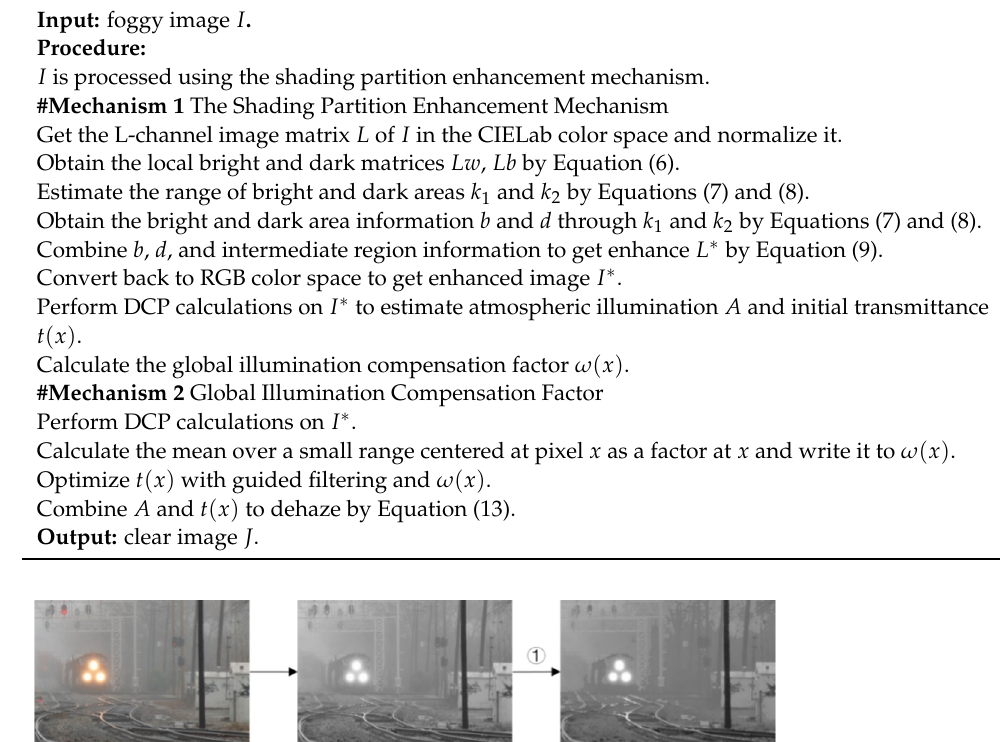
Algorithm 1. Global Illumination Compensation-Based Image-Dehazing algorithm.